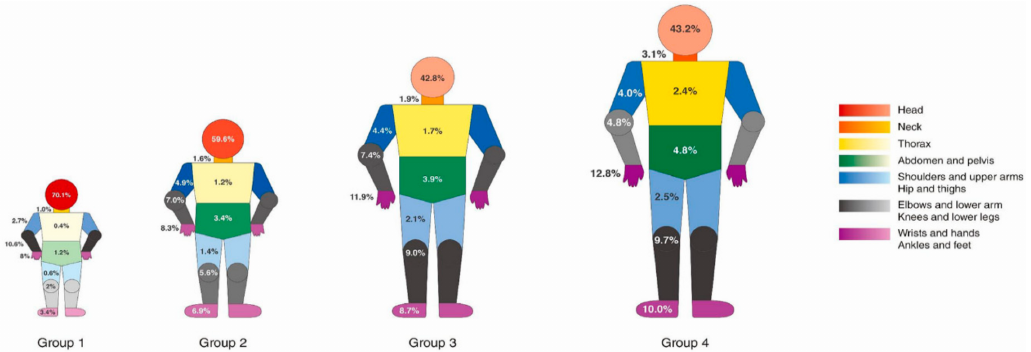
Figure 4. Anatomical sites of the injury can be seen according to age group. The sites that are more prone to injury are shaded with a darker color. Group 1 (0 to 4 years), group 2 (5 to 9 years), group 3 (10 to 14 years), group 4 (15 to 19 years).